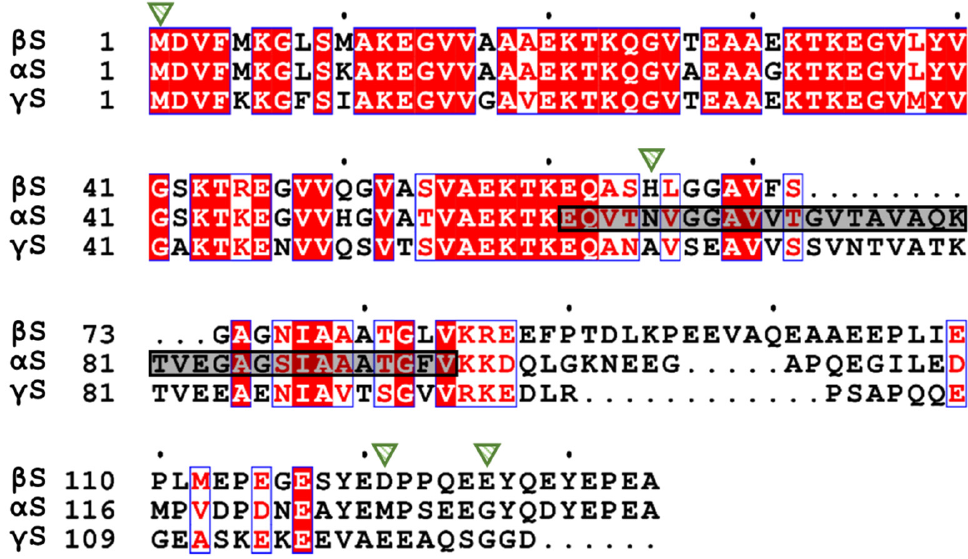
Figure 1. Amino acid sequence alignment of human α -, β -, and γ -synucleins. The one-letter amino acid code in the red shaded boxes with white text and the blue outlined boxes with red text represent 100% sequence similarity and amino acids with similar chemical properties, respectively. The black dots are placed at every 10 amino acid intervals of β S. The inverted green triangles represent the metal binding residues of β S. The gray shaded box with the black outline in the α S sequence represents the NAC region (E61-V95) in α S. M1-K60 in all three proteins encompass the N-terminal region, and K85-A134 refers to the C-terminal region of β S. The multiple sequence alignment was performed on the Network Protein Sequence @nalysis server using CLUSTAL W (1.8) [12] and visualized using Easy Sequencing in PostScript ESPript 3.0 [13].